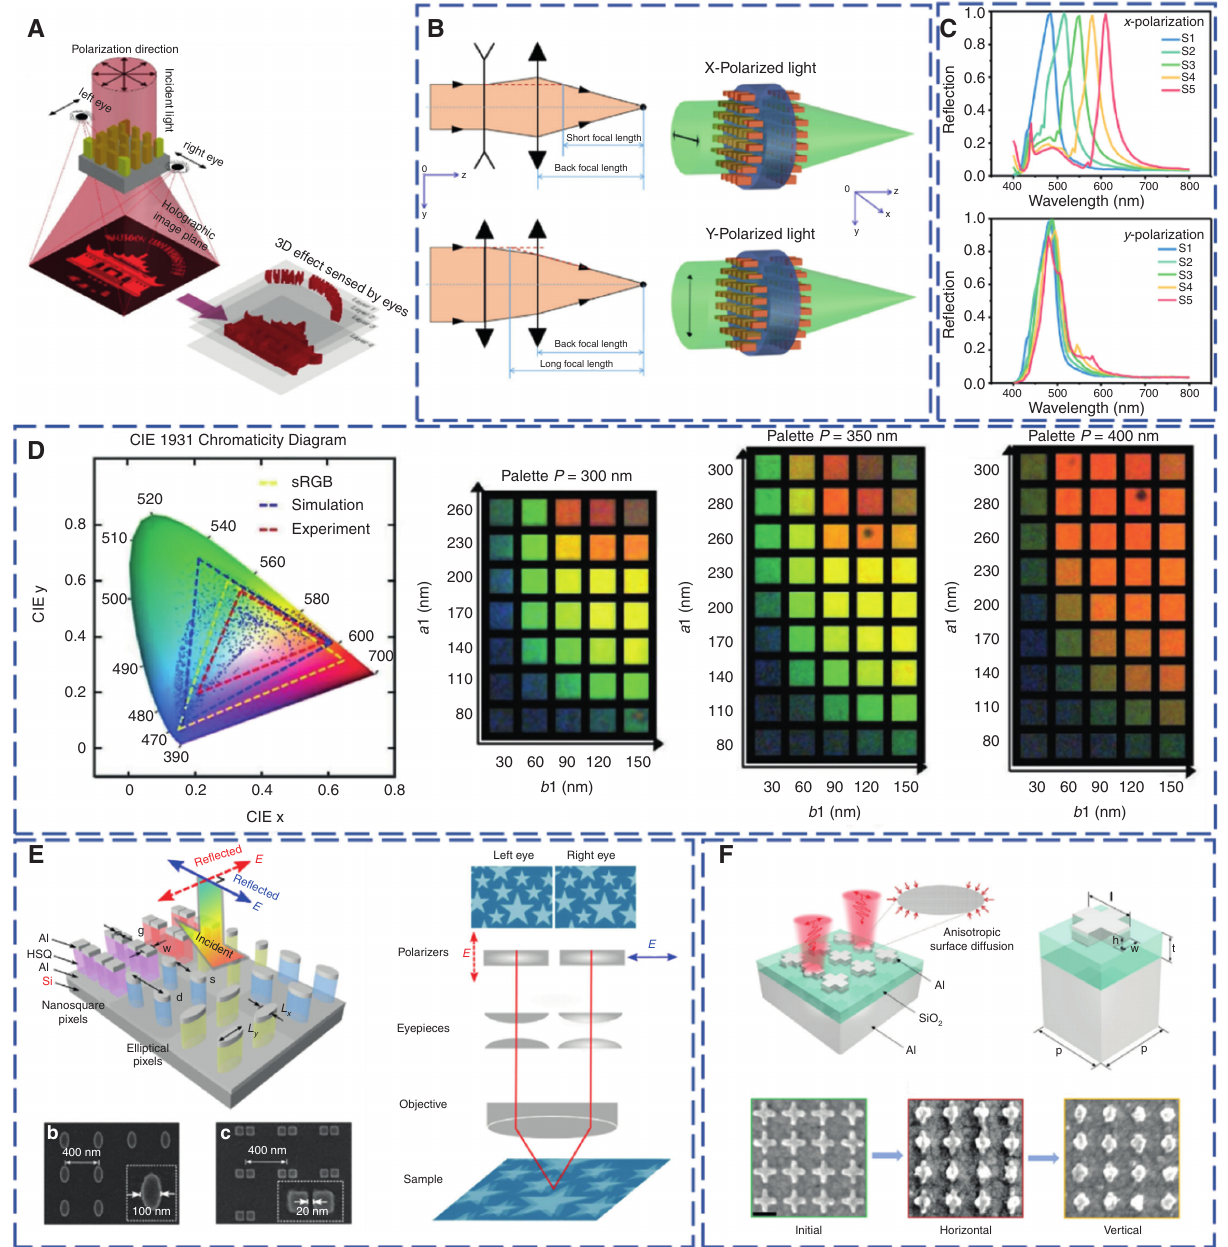
Figure 6: Anisotropic nanostructures with independent control of the phase and color in the orthogonal polarization directions. (A) 3D holographic display [55]. (B) Dual step-zoom metalens [56]. (C) Independent control of the spectral response in the orthogonal polarization directions [57]. (D) Wide-band full-color display [58]. (E) 3D nanoprintings for color image display [59]. (F) Metasurface fabrication using in situ anisotropic thermographic laser printing technology [60]. Reprint permission obtained from